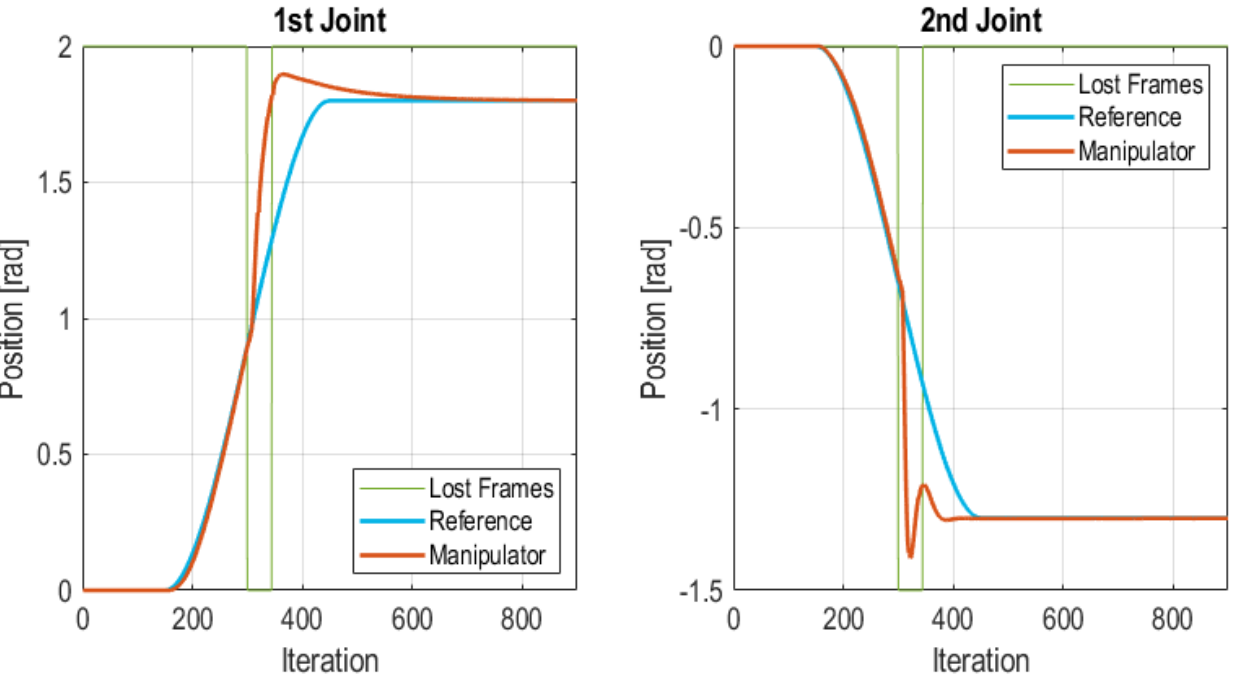
Figure 15. Burst of frames lost at the middle of transitory state.